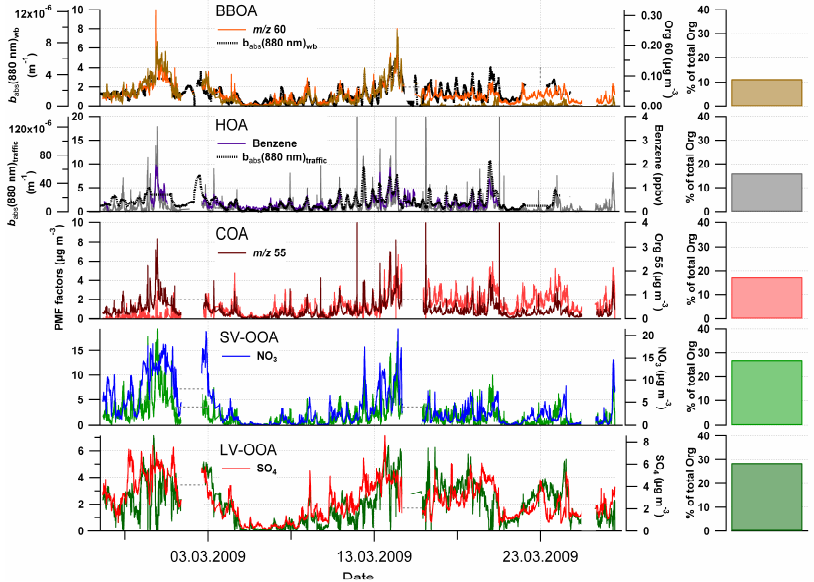
Fig. 3. Time series of the 5-factor-PMF solution and ancillary data. The right panels show the relative contributions of the respective factors to OA.